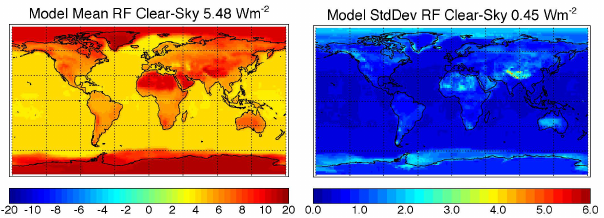
Fig. 13. Annual mean short-wave all-sky top-of-atmosphere radia- tive forcing (RF) with AOD=0.2 distributed over the lowest two kilometers between experiments with SSA=0.8 and SSA=1.0 with holding ANG=1.0 constant